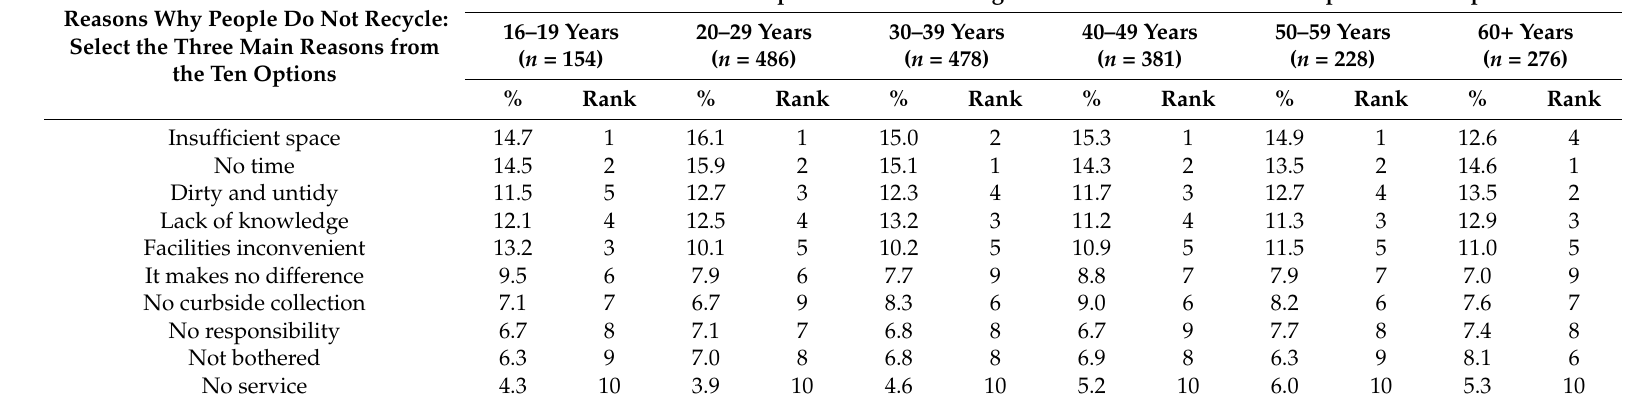
Table A1. Reasons why people do not recycle as enumerated per age group ( n = 2003 *).